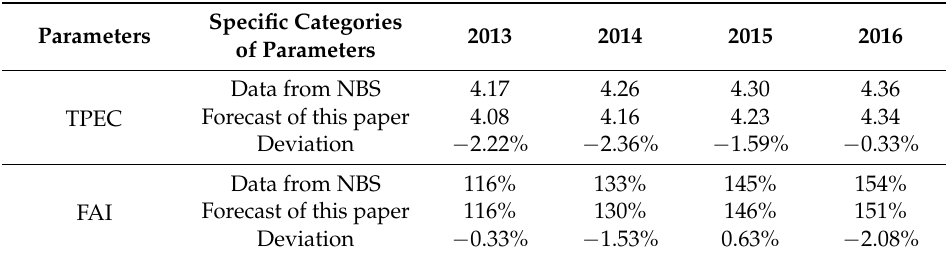
Table 9. The comparison of the forecast and data published by National Bureau of Statistics (NBS) (billion tons of coal equivalent, Gtce).